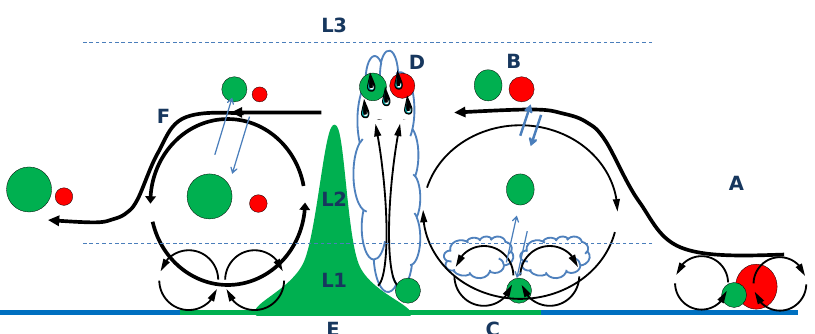
Fig. 14. Conceptual illustration of the dynamical processes as would be expected in local afternoon. Air mass travels from east (right) to west (left). Sulphate and organic aerosol are represented by red and green circles respectively, with circle size indicative of aerosol loading. Layers One, Two and Three indicated by L1, L2 and L3 with divisions marked with dashed line. It should be noted that the layer divisions were different between place and time. (A) Sulphate and organics in a shallow marine boundary layer carried by synoptic flow. (B) Synoptic flow is opposed to the sea-breeze circulation which is weakened. Turbulent mixing occurs between top of cell and synoptic flow. The shallow aerosol layer observed upwind is lofted above the island surface layer. (C) Shallow well mixed layer capped with cumulus clouds. (D) deep convective uplift lofts more organic aerosol, with precipitation events removing the regional aerosol. (E) Orography induces uplift. (F) Synoptic flow strengthens sea-breeze circulation. Some transfer of aerosol from synoptic flow to sea-breeze circulation which is recirculated. Not to scale. 50